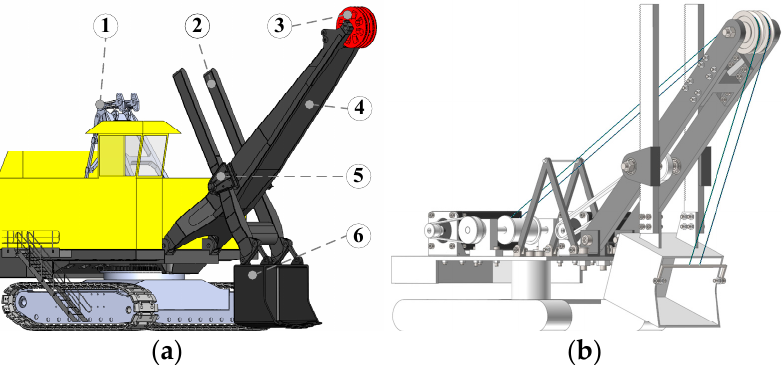
Figure 1. ECS model and ECS scale model: ( a ) an ECS model and its main structural members ( ① A frame, ② dipper handle, ③ boom point sheave, ④ boom, ⑤ saddle block, ⑥ dipper); ( b ) a 1/30 scale model of the ECS.